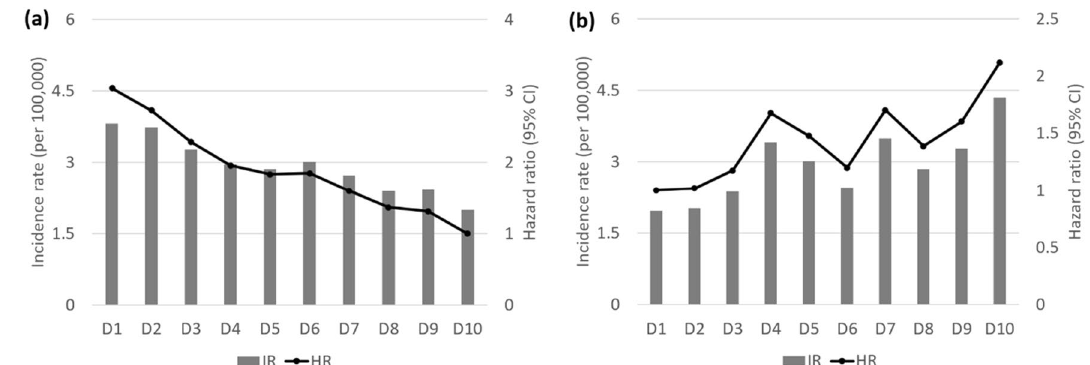
Figure 2. Incidence rates (IRs), hazard ratios (HRs), and 95% confidence intervals (CIs) of Behçet’s disease by deciles of high-density lipoprotein cholesterol mean ( a ) and variability ( b ). Adjusted for age, sex, body mass index, alcohol use, smoking, exercise, income, diabetes mellitus, hypertension, and mean high-density lipoprotein cholesterol.